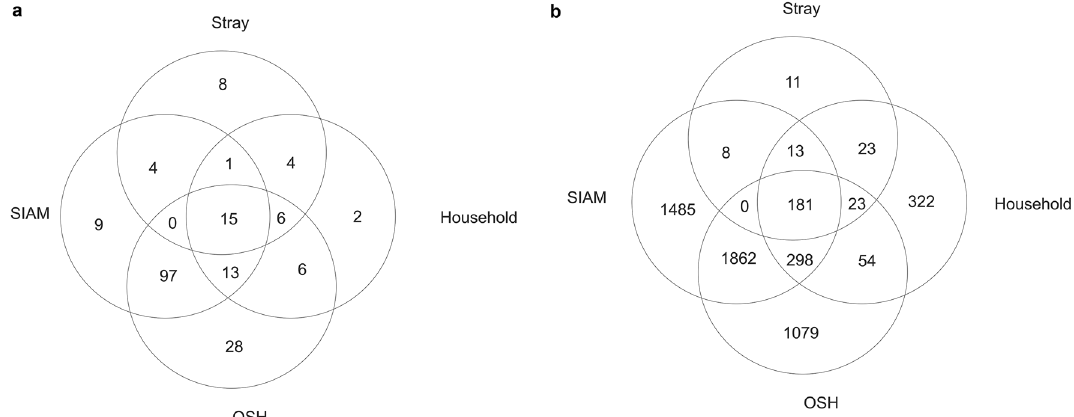
Figure 6. Comparison of the 10% consensus ROHs of stray, household, OSH and SIAM. Shown are the number of ROHs ( a ) and the number of genes in the ROHs ( b